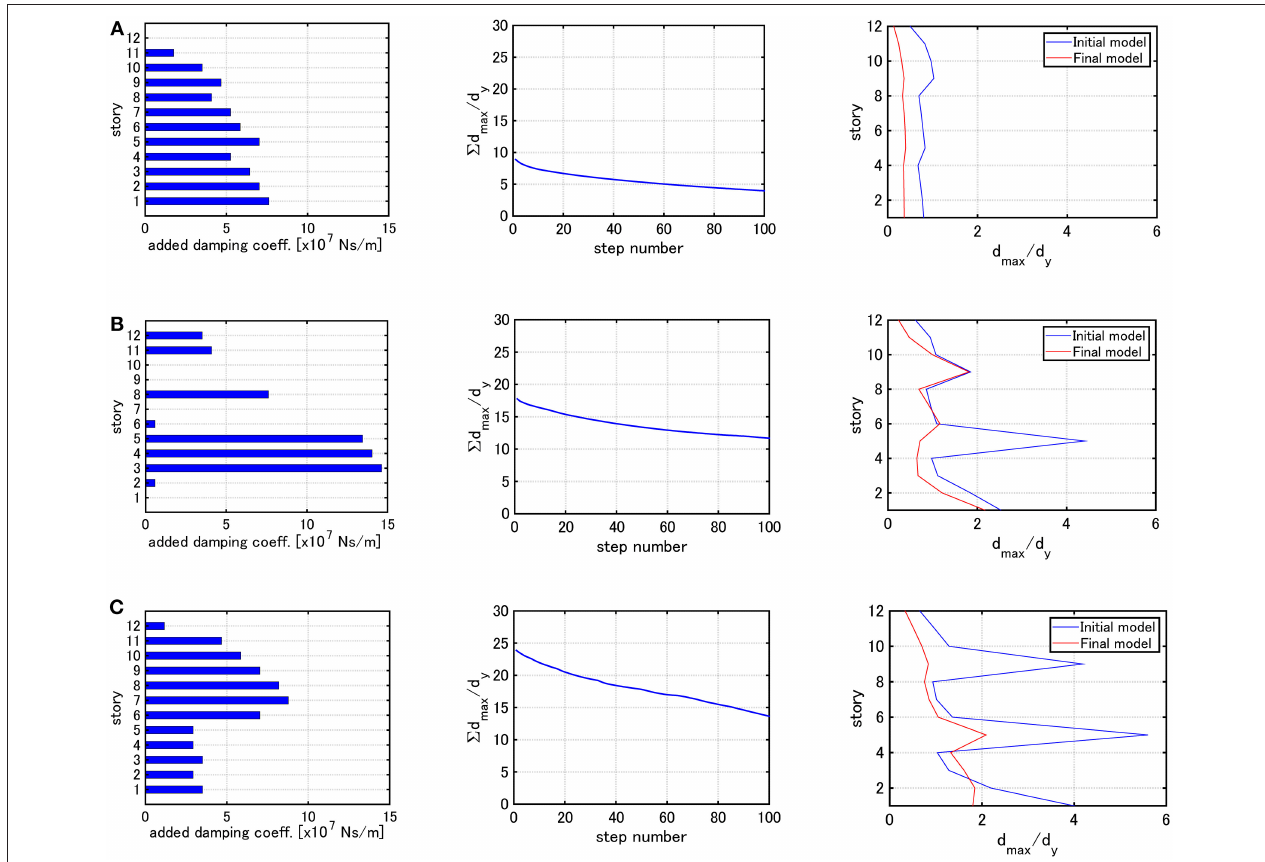
FIGURE 11 | Distribution of added damping coefficients, P d max , i / d y with respect to step number and the distribution of d max , i / d y under the critical double impulse for Model 3 (Problem 2): (A) Elastic limit, (B) V = 0.84[m/s], (C) V =